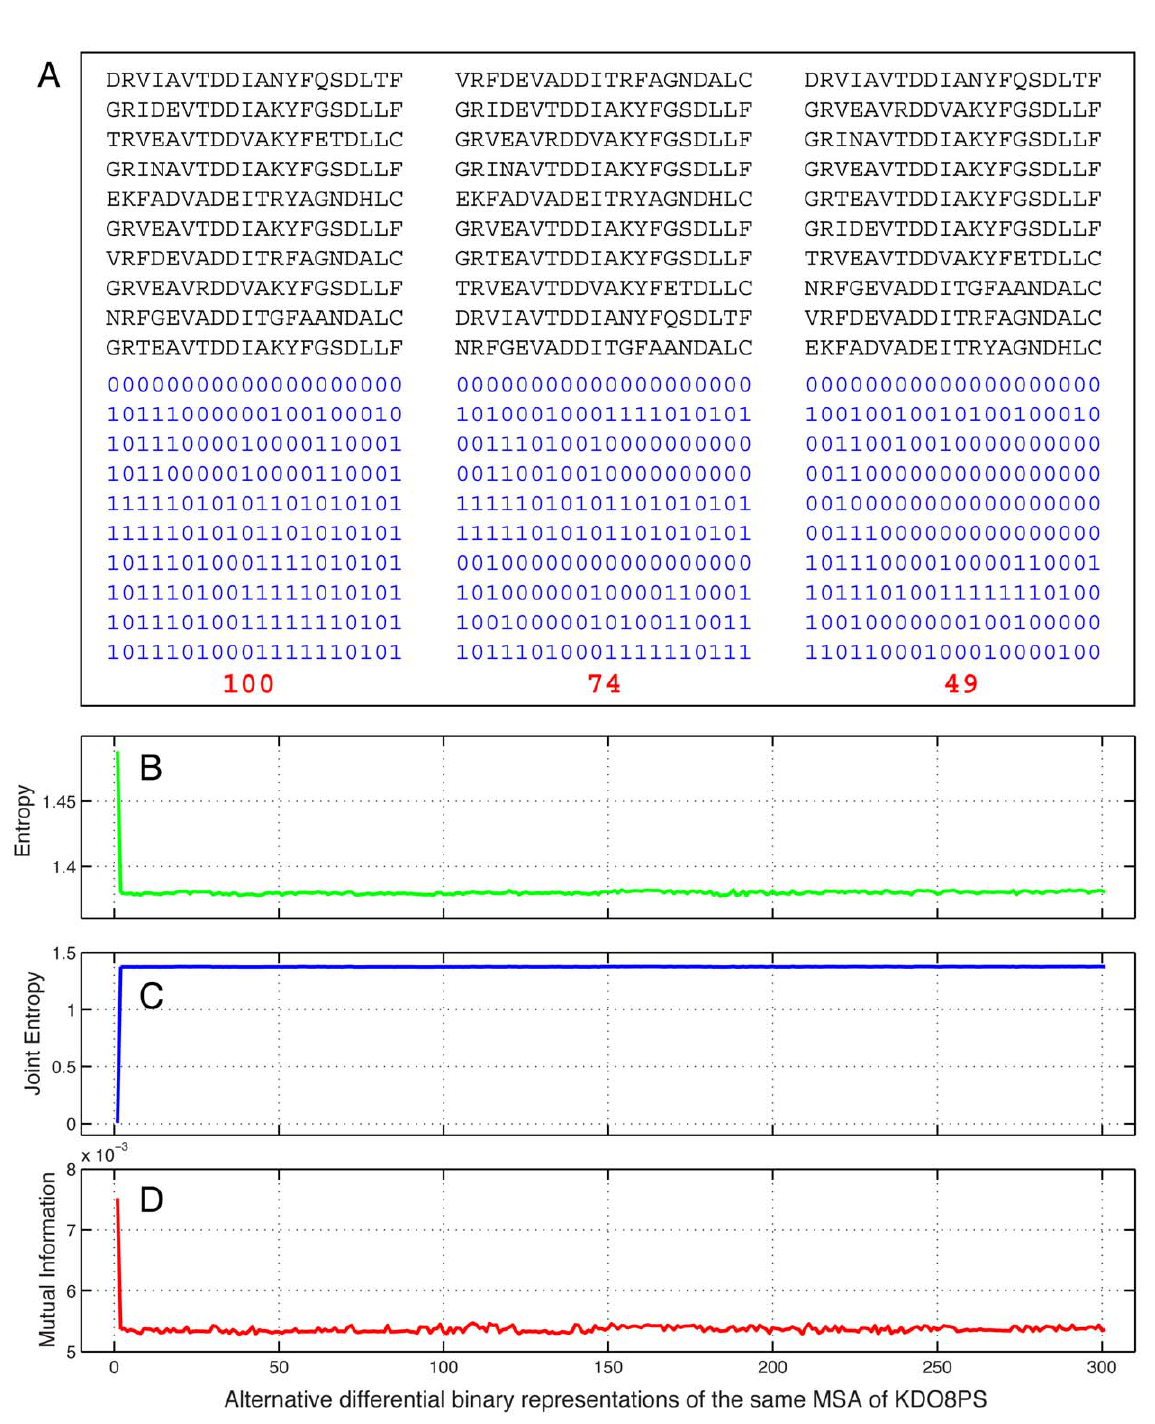
Figure 1. The differential binary (db) method. A. Resorting of the MSA and differential binary translations. The upper half of the panel shows the same 10 sequences in three different orders. The lower half of the panel shows the corresponding differential binary translations, with the values of the sums highlighted in red. The order of sequences on the left produces the highest sum (=100) after differential binary translation. The order in the middle produces an intermediate value (=74) of the sum, while the order on the right produces the smallest possible sum (=49) of any resorting of the sequences. B. Entropy changes in the binary translations of a simulated MSA of KDO8P synthase. The first point in the plot is the mean entropy , H( i + j ) . = , H( i ) + H( j ) . of the unsorted binary MSA. The remaining points are the values of the same quantity in each of the 300 possible binary MSAs obtained by first resorting the original MSA, using in each case a different reference sequence (which is assigned a value of 0 in all the positions). C. Same as B but reporting on the mean joint entropy , H( i,j ) . of all possible pairs. D. Mean mutual information , MI( i ; j ) . = , H( i ) + H( j ) 2 H( i,j ) . for all possible pairs.